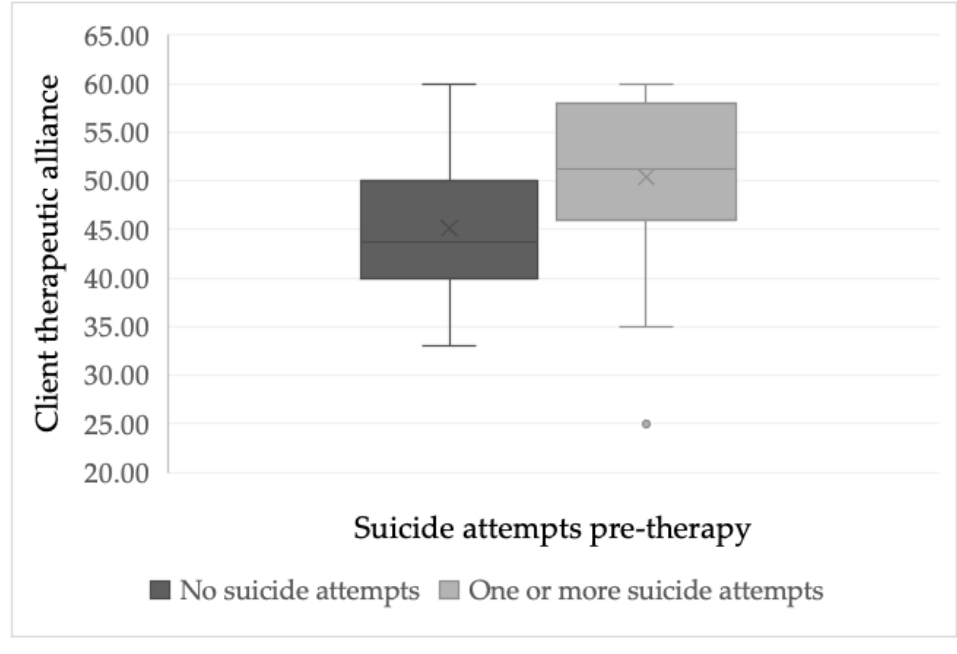
Figure 1. A boxplot chart illustrates the distribution of client therapeutic alliance scores between clients who had and had not attempted suicide during the 6 months prior to starting therapy.